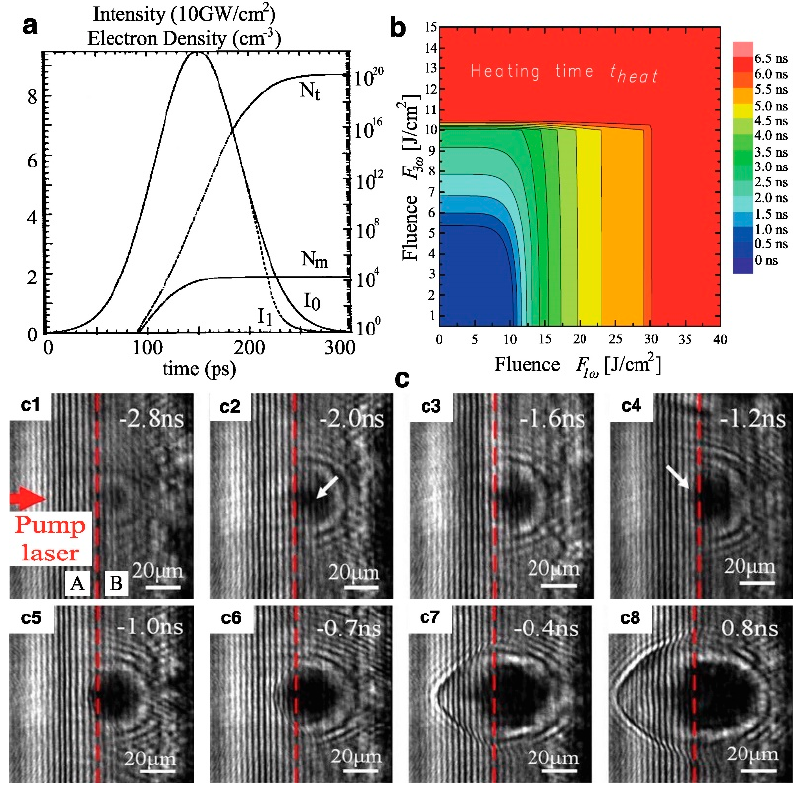
Figure 7. The process of energy deposition and evolution of dielectric under short pulse laser irradiation. ( a ) Curve of the total electron density (N t ) and multiphoton produced electron density (N m ) with incident (fluence 10.1 J / cm 2 ) and transmitted (fluence 9.7 J / cm 2 ) laser pulse, τ = 100 ps [70]; ( b ) Evolution of t heat of KDP as a function of the fluences F 1 ω and F 3 ω [71]; and ( c ) The transient images of plasma produced by early ionization with the delay between pump and probe pulse of − 2.8 ns to 0.8 ns, the area A on the left side of the red dotted line is air, and B on the right side is KDP [69].